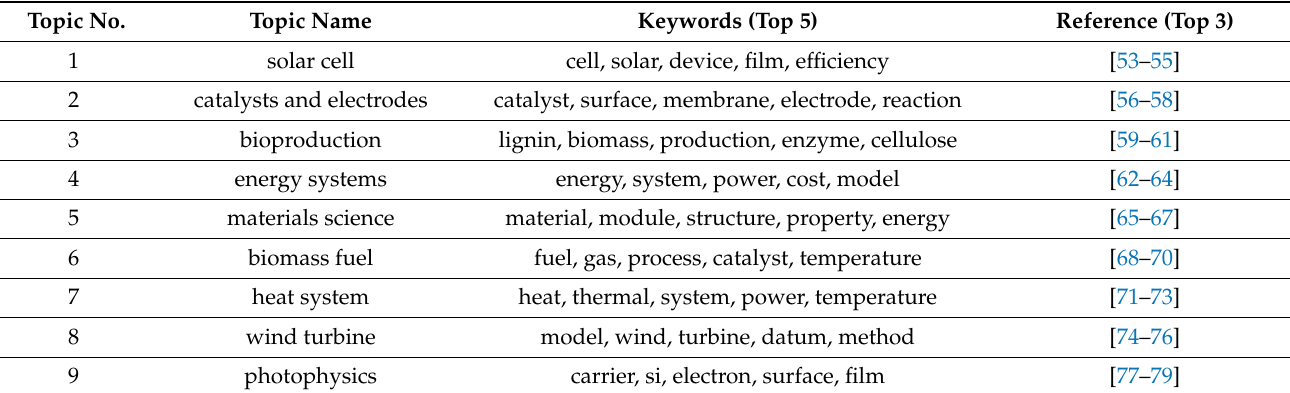
Table 1. The main topic and top 5 keywords for each topic